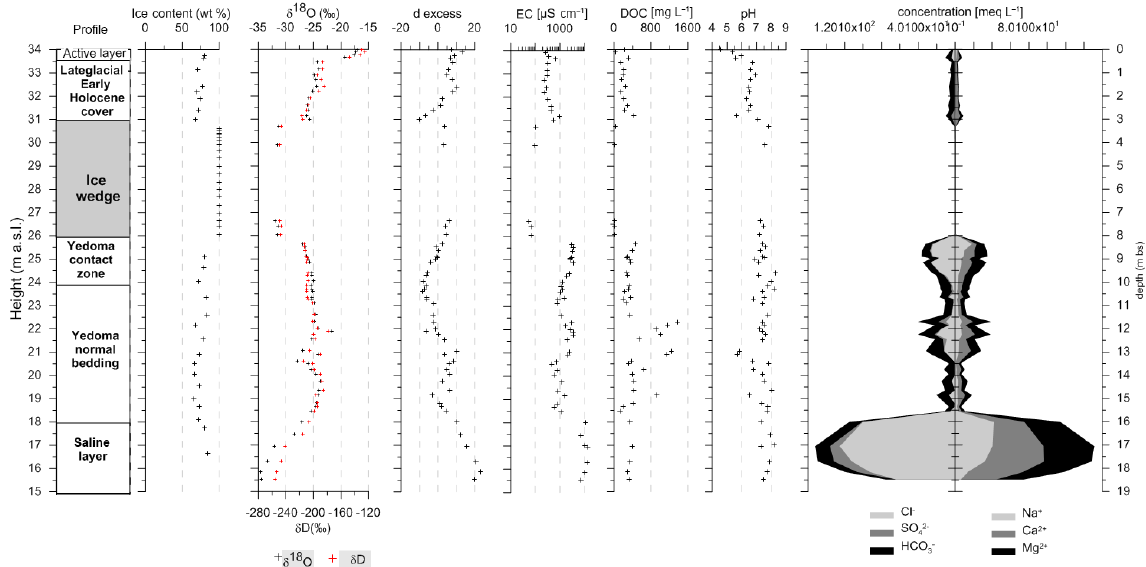
Figure 11. Measurements of ice content, isotope ratios, electrical conductivity (EC), pH, and solutes over depth for samples from the BK-8